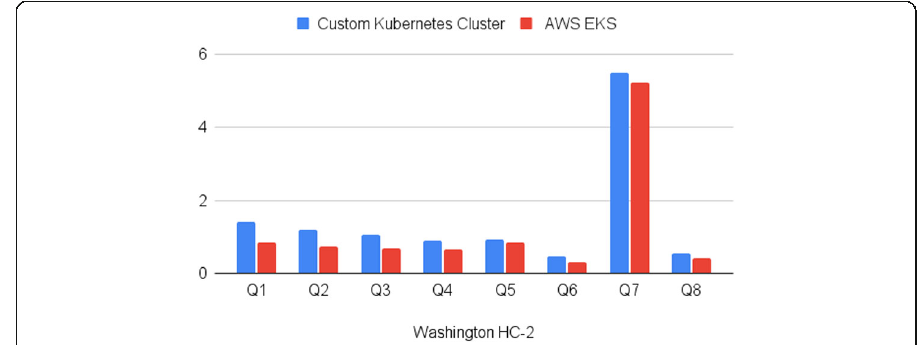
Fig. 17 Query execution time for AWS EKS vs local Kubernetes cluster for Washington